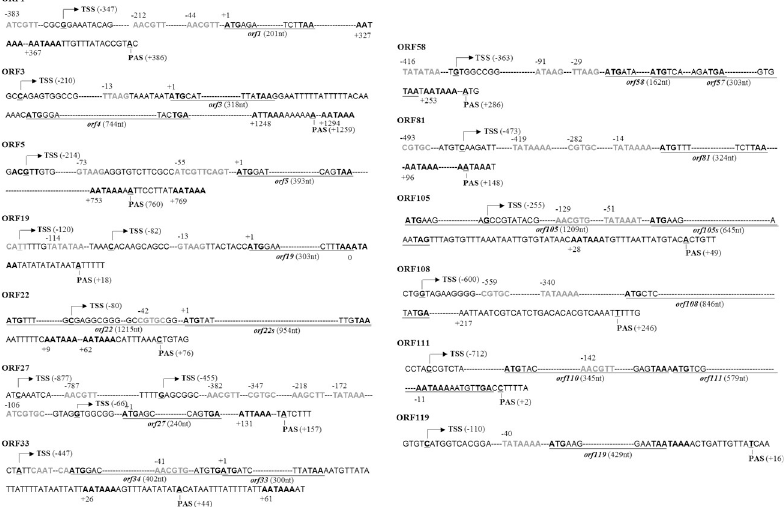
Fig 5. Structures of the transcription cassettes of PlxyGV-specific genes. The transcription start sites are in bold and underlined, and transcription direction are indicated by arrows. The major promotor elements, TATA boxes, A(A/T) CGT(G/T), CGTGC, and A/G/TTAAG motifs are present in grey bold. Their positions relative to the initiation ATG of the individual PlxyGV-specific ORFs are shown by the numbers above. The initiation ATG and stop codons are in black bold and underlined. The transcription terminator elements, AATAAA and ATTAAA are in black bold and their positions relative to the stop codons of individual PlxyGV-specific ORFs are indicated by the number